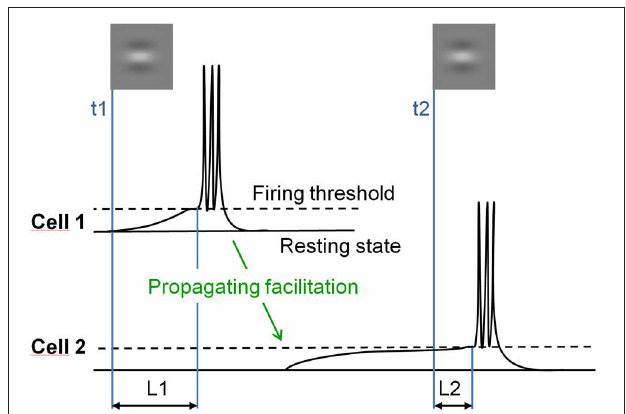
FIGURE 1 | Illustration of the hypothesis. Responses of two orientation selective V1 neurons with co-aligned non-overlapping receptive fields stimulated in succession. Cell 1, stimulated first at time t1, depolarizes its neighbors through long-range horizontal connections with slow propagation speed (green arrow). Stimulation of the depolarized cell 2 at time t2 results in shortened response latency (L2), as compared to the response latency of cell 1 to the first input